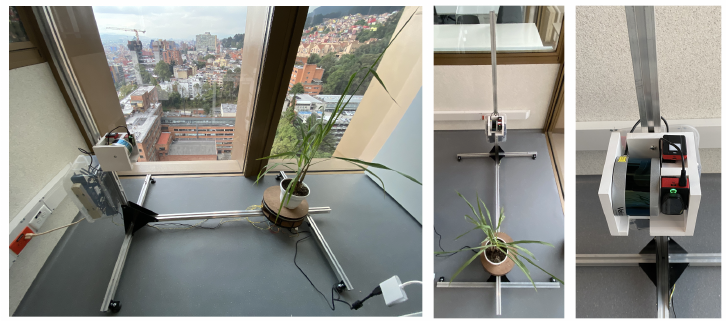
Figure 2. Mechanical structure for the 4D phenotyping platform.